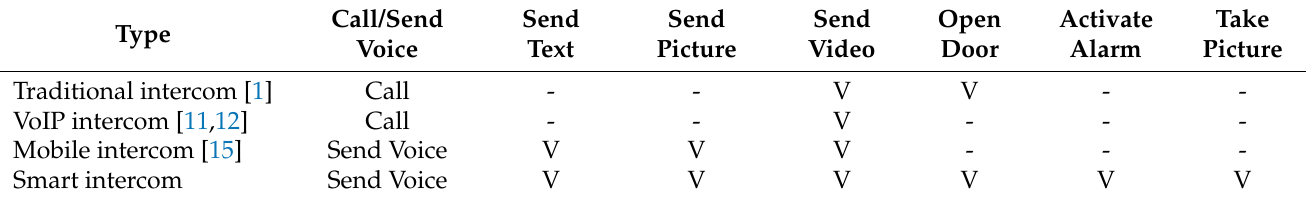
Table 4. Intercom use functions list.